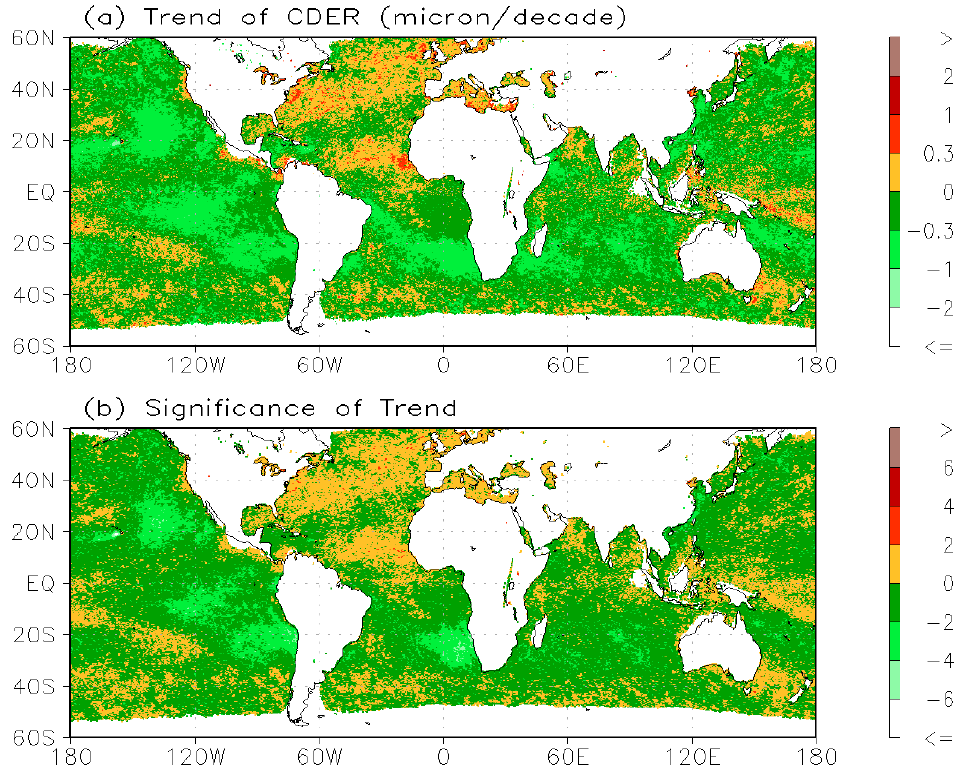
Figure 15. Global maps of ( a ) the linear trend and ( b ) the significance of the trend for CDER monthly mean values from 1981 to 2011. A signi fi cance >+2 (or < − 2) indicates the increasing (or decreasing) tendency detected is above 95% confidence level.